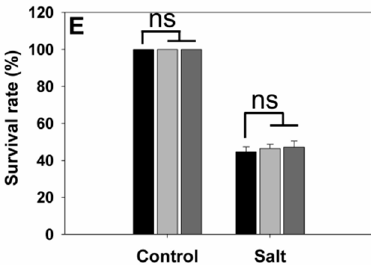
Figure 5. Growth performance in response to salinity stress of complementation lines compared with WT. Growth conditions and treatments were the same as given in Figure 1. Growth performance of WT and the complementation lines under normal ( A ) or 100 mM NaCl treatment ( B ). Bars = 5 cm. ( C – E ), AsA content ( C ), germination rate ( D ), and survival rate ( E ) of the seedlings under normal and salt stress. The values are means ± SE of five replicates. FW—fresh weight; ns indicates non-significant differences.